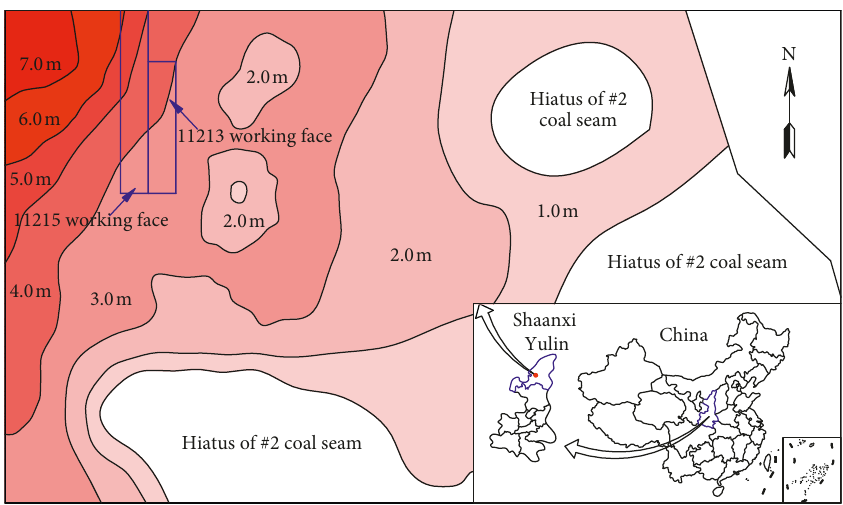
Figure 1: Thickness distribution of #2 coal seam in the Xiaojihan coal mine.